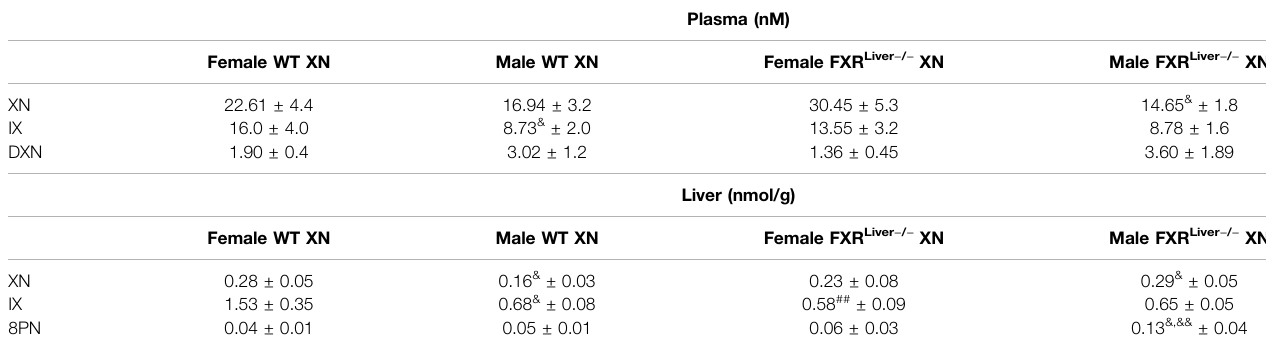
TABLE 2 | Concentrations of XN and metabolites (IX, 8PN, DXN) in the plasma and liver of females vs. males HFD-fed WT and FXR Liver − / −